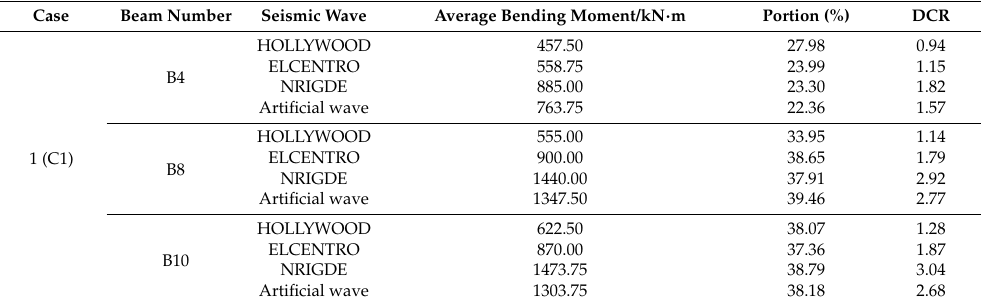
Table 11. Force condition of beams in case